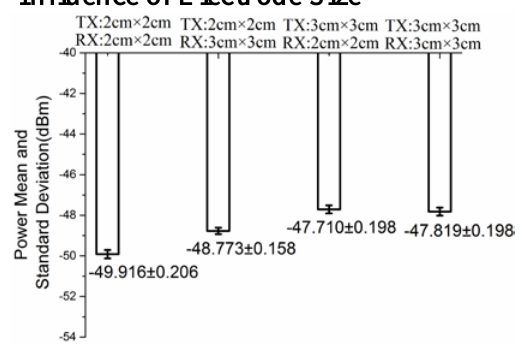
Figure 7. The influence of electrode